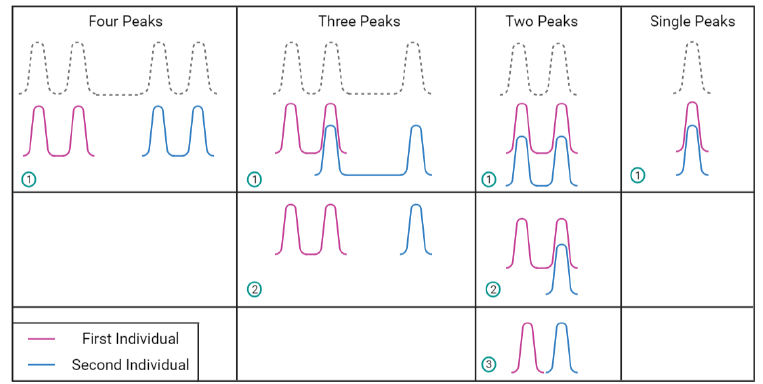
Figure 7. Possible genotype combinations in two-person mixture.